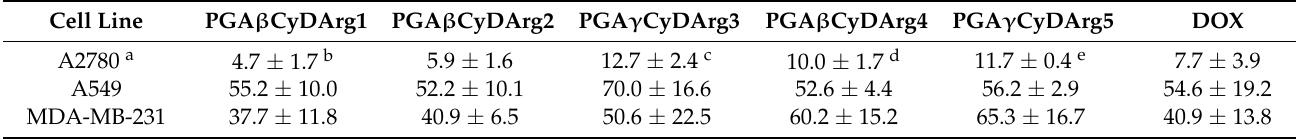
Table 2. Half maximal inhibitory concentration (IC 50 ) values (nM) of doxorubicin (DOX) in the presence of CyD polymers in human tumor cells. Cell